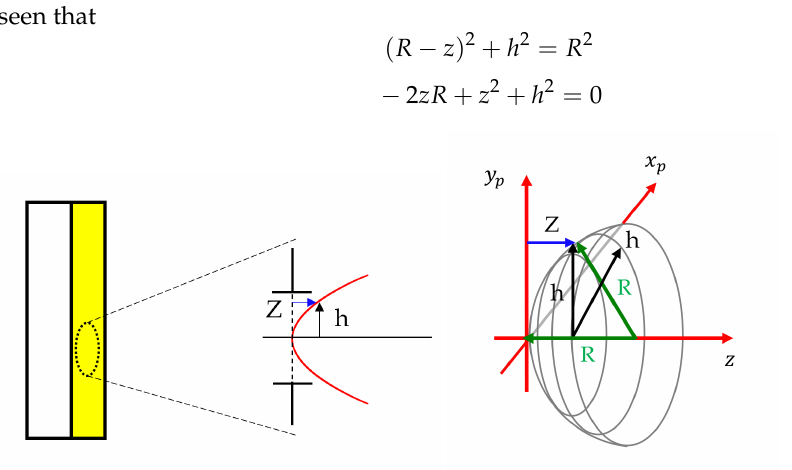
Figure 3. Geometry for obtaining the impulse response (ASF) of the